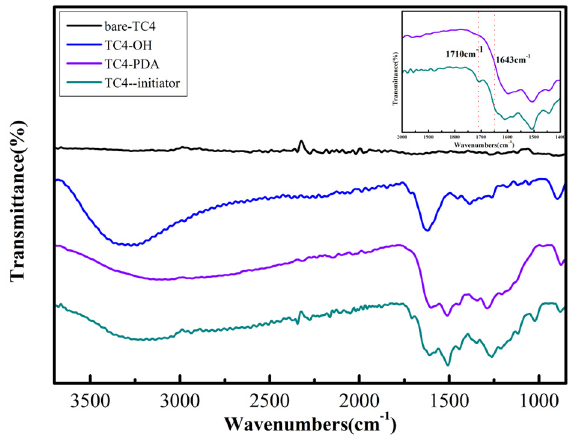
Figure 1. FT − IR spectrum of bare TC4, TC4-OH, TC4-PDA, TC4-initiator.